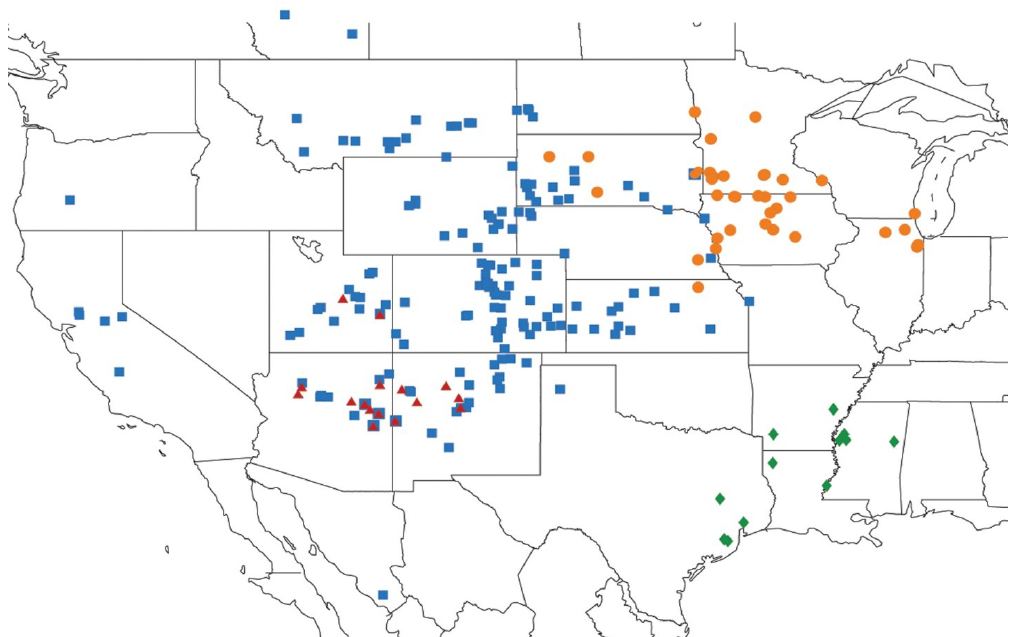
Figure 49. Distribution of Okanagana synodica synodica (blue squares), O. synodica nigra (red triangles), O. balli (orange circles) and O. viridis (green